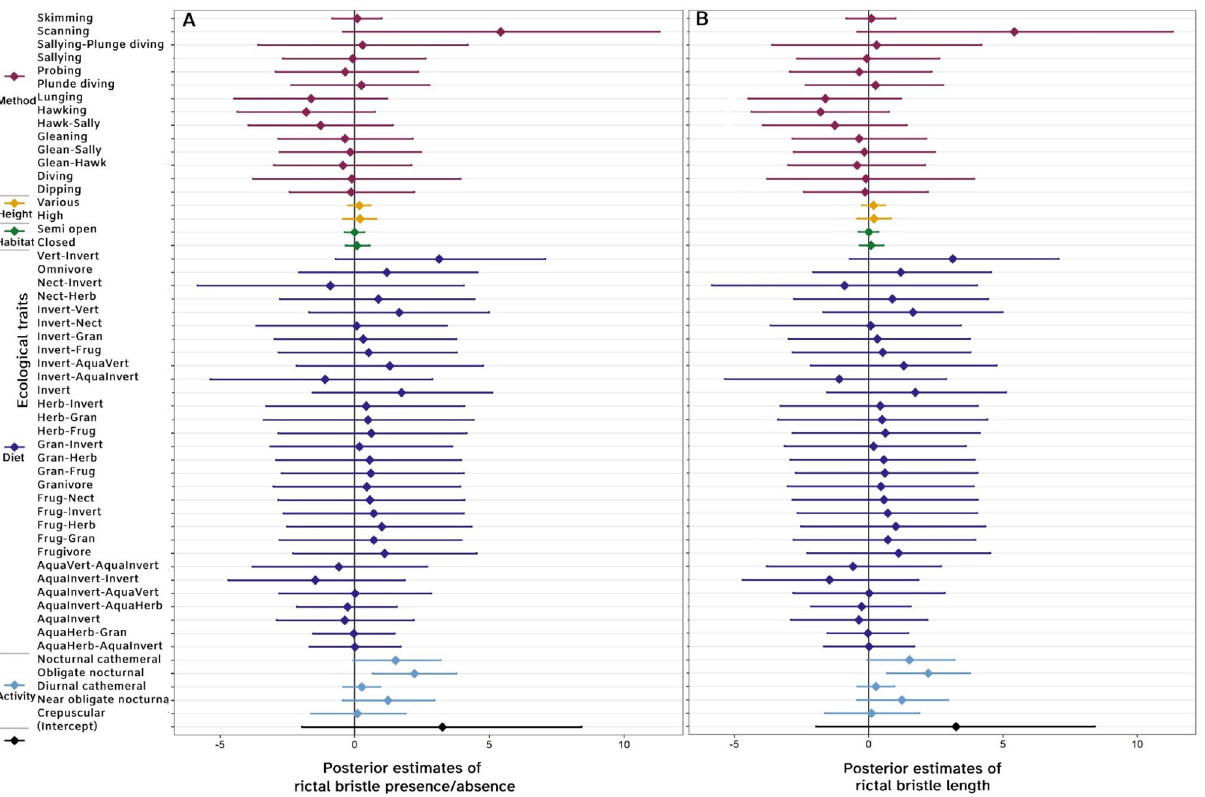
Figure 4. Caterpillar plots representing the posterior mean estimates and the 95% credible intervals for each ecological predictor in models, rictal bristle presence and length models. The colours of the bars represents the different ecological traits: activity period in blue, diet in dark purple, habitat type in green, foraging height in yellow, foraging method in dark magenta, and the model intercept in